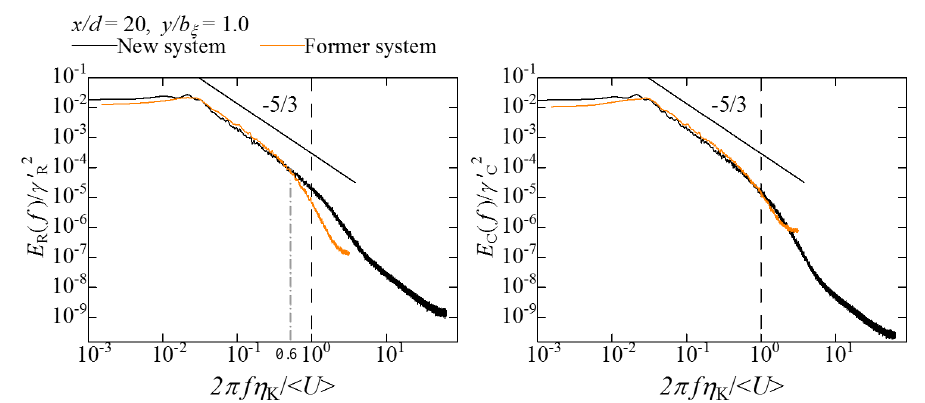
Fig. 11 The lateral profiles of the normalized rms values of concentration fluctuations of product R, (cid:13) R ′ =(cid:0) R0 , and non-reactive species C, (cid:13) C ′ =(cid:0) C0 , obtained by the new system ( (cid:15) ) and the former system ( △ ) at x = d = 20.